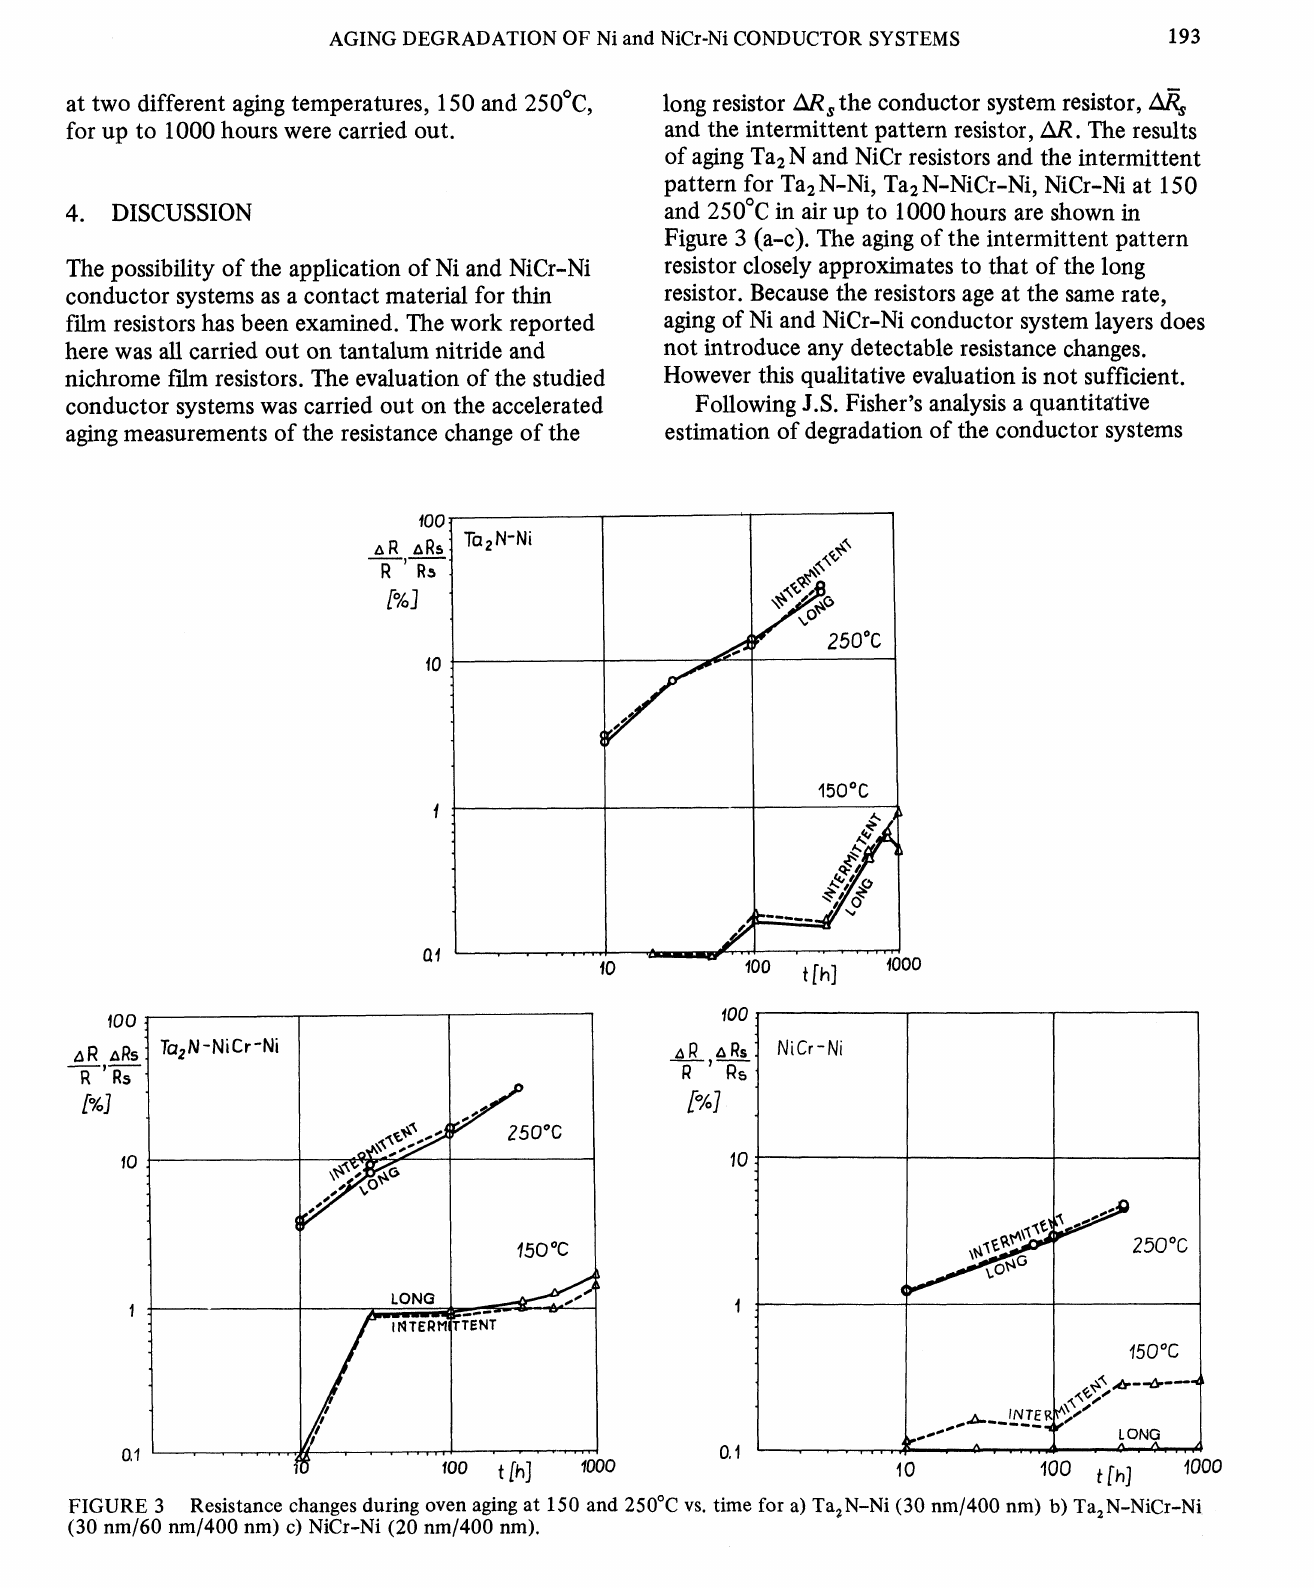
Resistance changes during oven aging at 150 and 250C vs. time for a) TaN-Ni (30 nm/400 nm) b) Ta2N-NiCr-Ni (30 nm/60 nm/400 nm) c) NiCr-Ni (20 nm/400